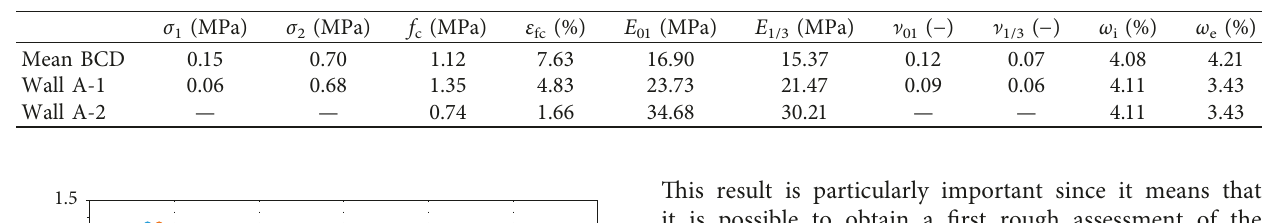
Table 4: Comparison between mechanical parameters obtained for Wall A tested at 0.025MPa/min and mean values obtained from other specimens (0.077 MPa/min).